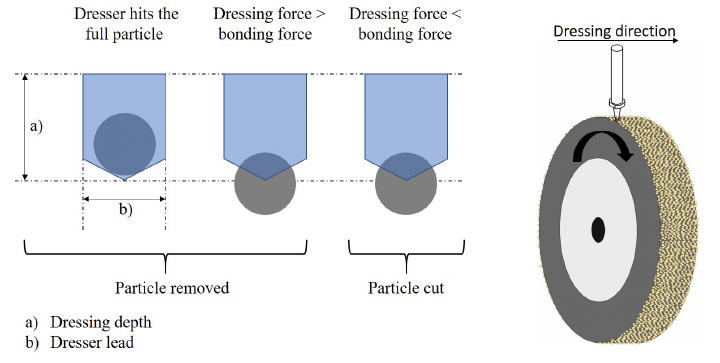
Figure 11. Visualisation of dressing process.